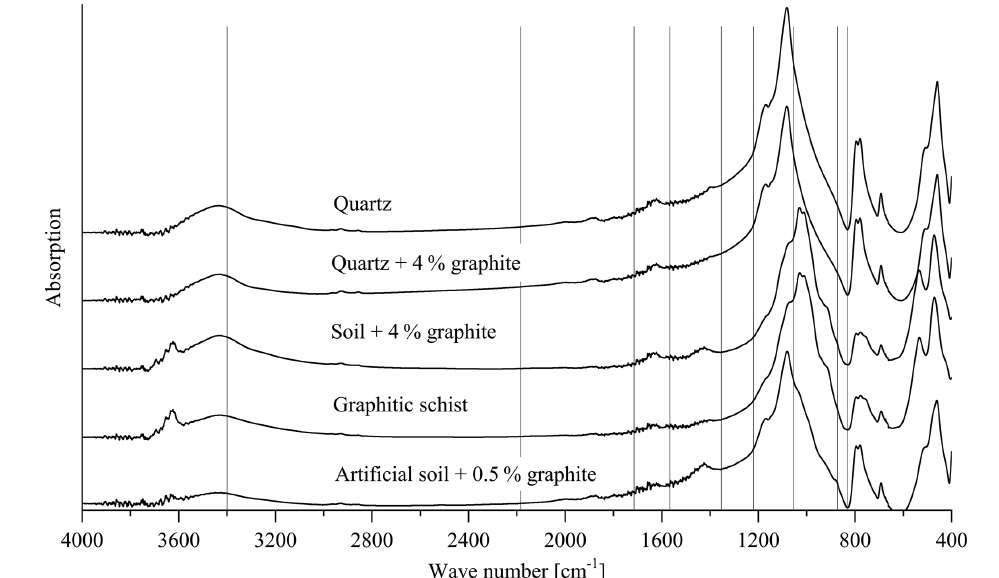
Figure 7. Transmission spectra of the pure quartz (calibration set 2, sample 1), quartz + 4% graphite (calibration set 2, sample 10), soil + 4% graphite (calibration set 1, sample 10), artificial soil 1 (0.5% graphite added) and graphitic schist. The vertical lines denote wave numbers for which absorption peaks have been reported in the literature (see